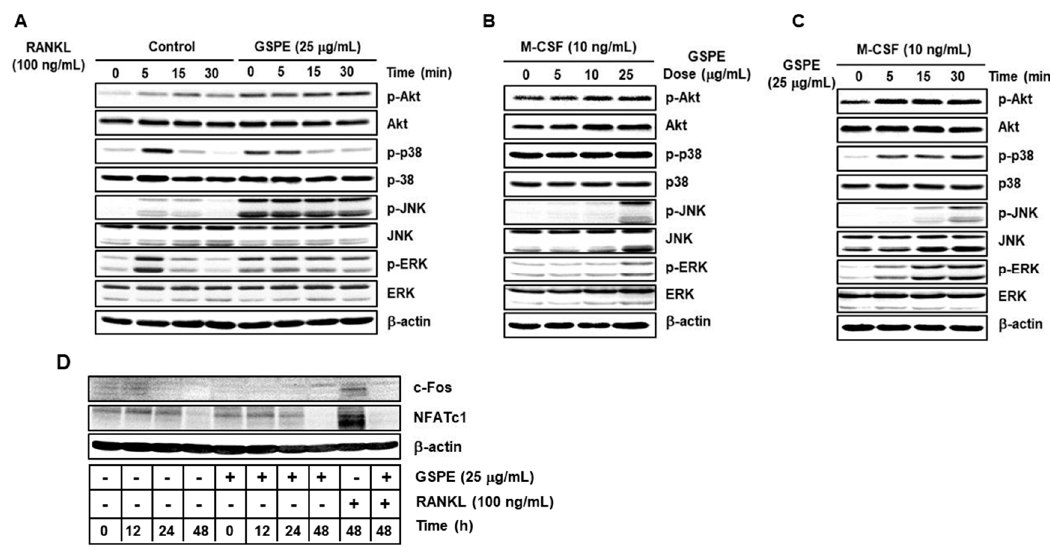
Figure 5. GSPE promotes the phosphorylation of components of the Akt and MAPK signaling pathways, including p38, JNK, and ERK. ( A ) Bone marrow macrophages (BMMs) were pretreated with 25 µ g / mL GSPE for 1 h in the presence of 10 ng / mL M-CSF, followed by stimulation with 100 ng / mL RANKL for the indicated time period. Western blot analysis of the whole-cell lysates was performed using the indicated antibodies. β -actin served as the internal control. ( B ) BMMs in the presence of 10 ng / mL M-CSF were stimulated with the indicated doses of GSPE for 15 min. ( C ) BMMs in the presence of 10 ng / mL M-CSF were stimulated with 25 µ g / mL GSPE for the indicated time period. ( D ) BMMs were stimulated with 25 µ g / mL GSPE in the indicated conditions. Co-stimulation with 100 ng / mL RANKL was performed for comparison. Whole-cell lysates were analyzed by performing Western blotting with the indicated antibodies. Abbreviations: GSPE, grape seed proanthocyanidin extract; RANKL, receptor activator of nuclear factor kappa-B ligand; c-Fos, cellular Fos; NFATc1, nuclear factor of activated T cells.